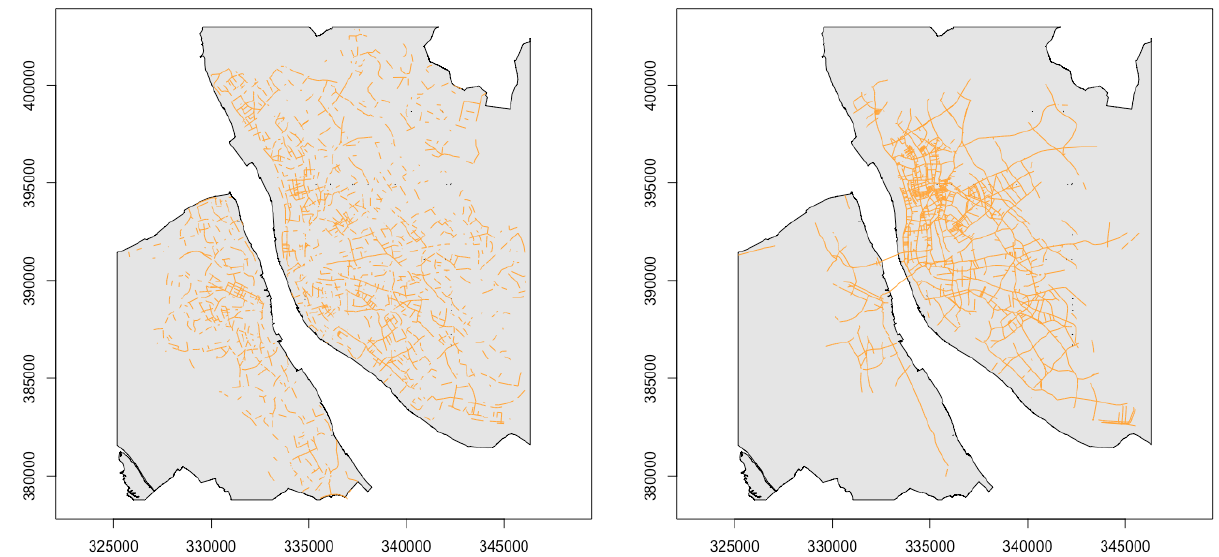
Figure 9. Urban morphological models for Liverpool based on Integration at scales of local (left) and global (right) radii. The maps represent the highest affordances for origin-to-destination movements at these scales (based on the top 20% Integration value